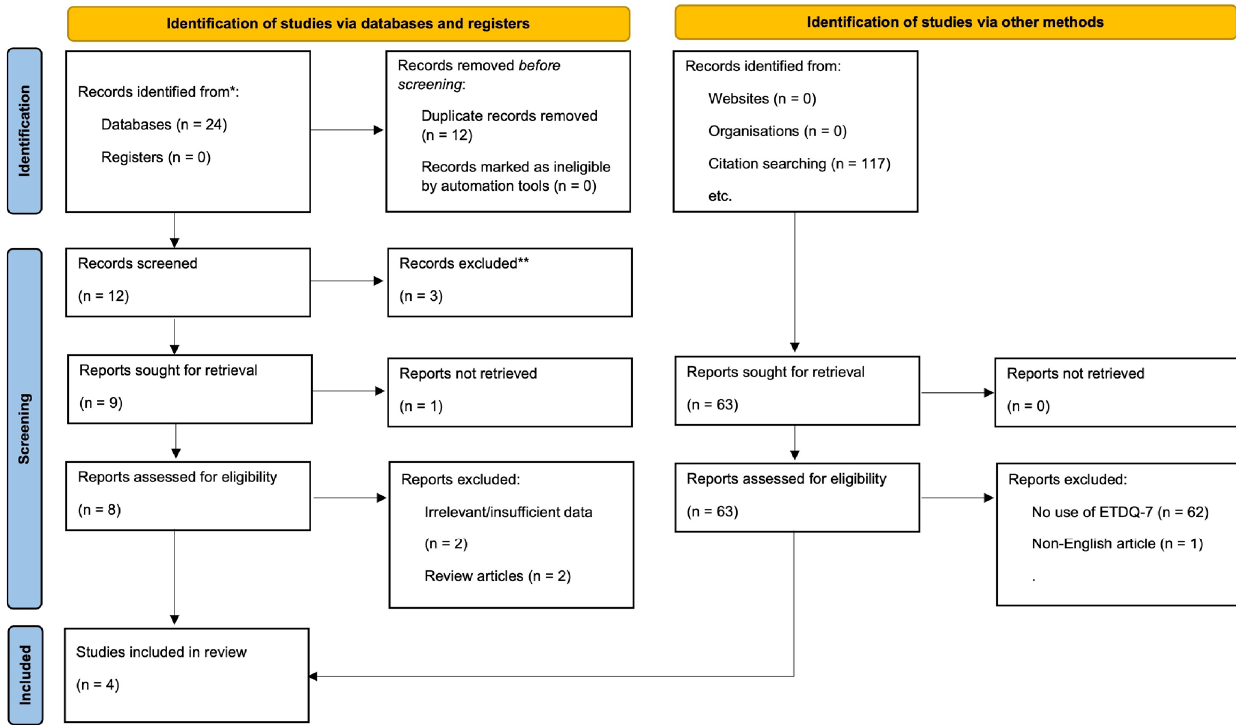
Figure 2. Forest plot of included studies. Forest plot showing significant pooled estimate suggesting a significant difference between the pre-opera- tive and post-operative sino-nasal outcomes which favour the impact of endoscopic sinus